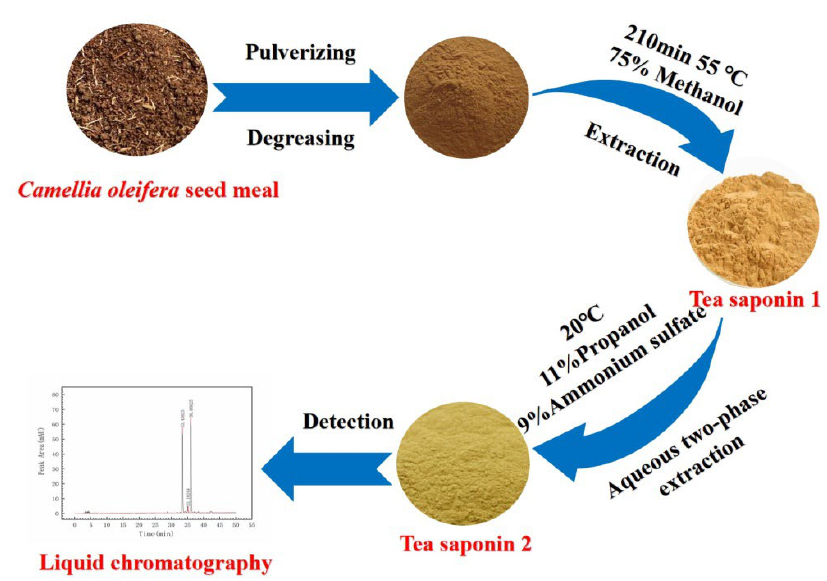
Figure 12. Extraction, purification, and detection of C. oleifera saponins.